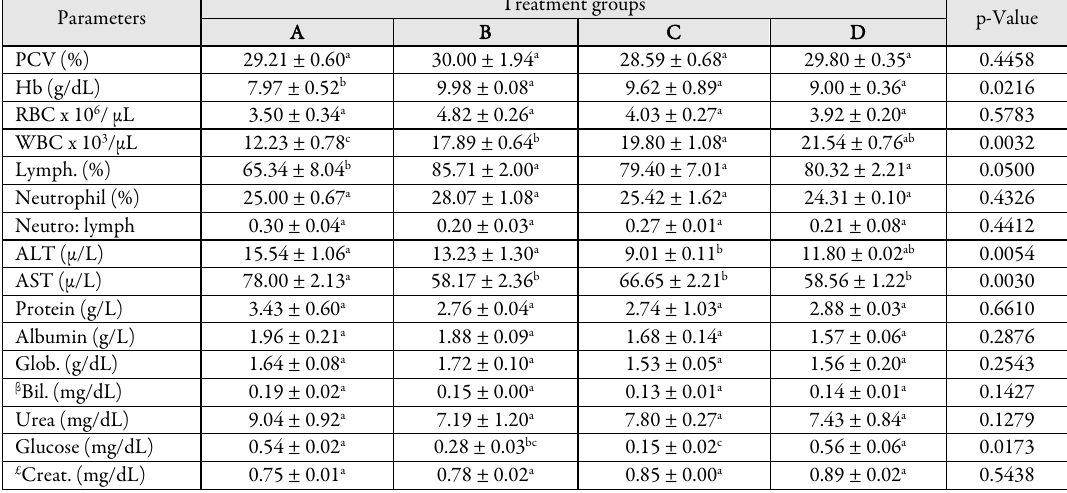
Table 3. Haematology and serum biochemistry of weanling piglets fed diets supplemented with graded